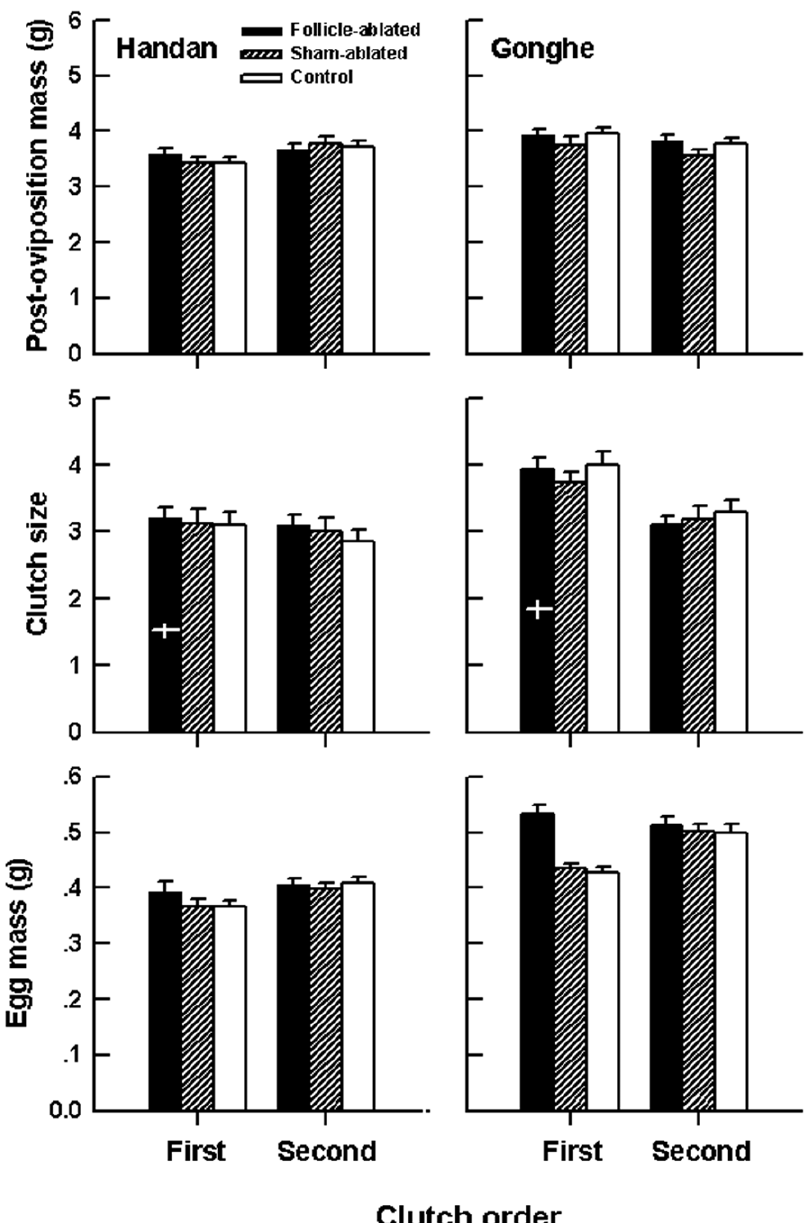
Figure 1. Mean values ( + SE) for post-oviposition body mass, clutch size and egg mass of the females involved. Clutch size for the follicle-ablated females was calculated as the sum of yolking follicles removed and eggs produced. Black, diagonal and open bars represent follicle- ablated, sham-ablated and control females, respectively. White horizontal and vertical lines represent mean and 6 SE for the actual number of eggs laid by follicle-ablated HD and GH females,